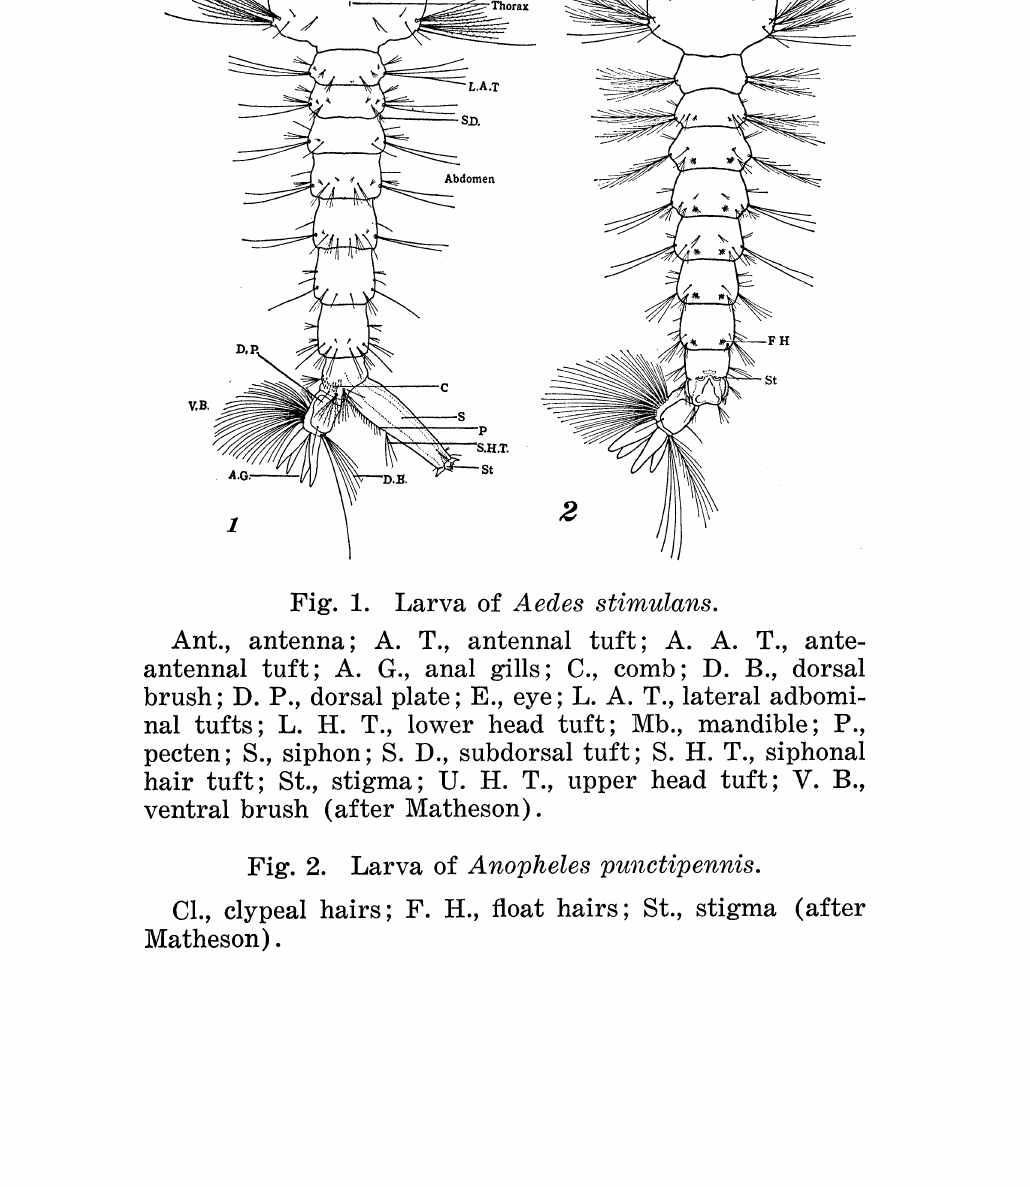
Fig. 1. Larva of A edes stimulans.